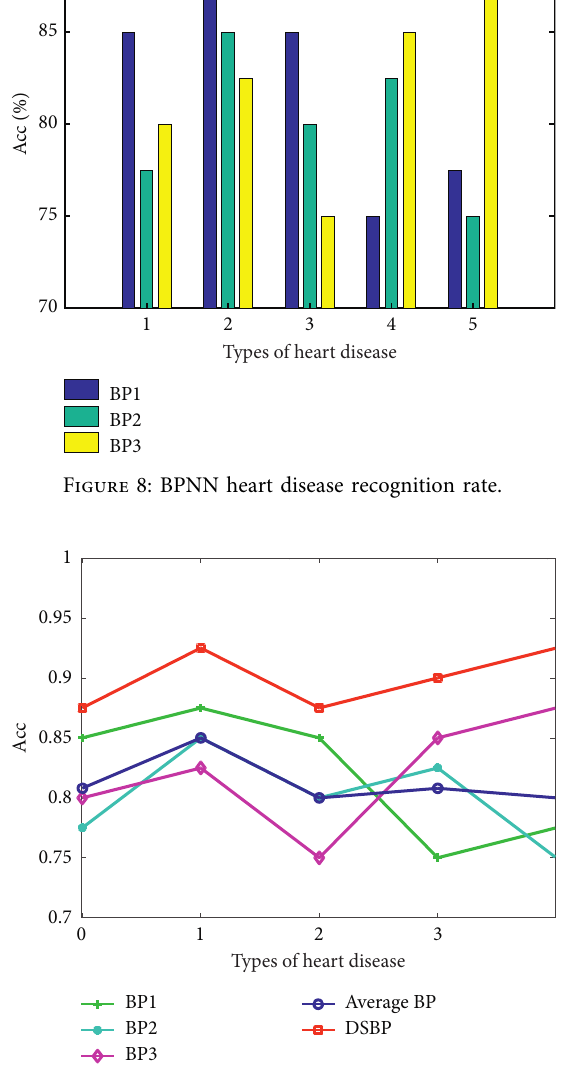
Figure 9: Comparison of prediction accuracy between BP algo- rithm and DSBP